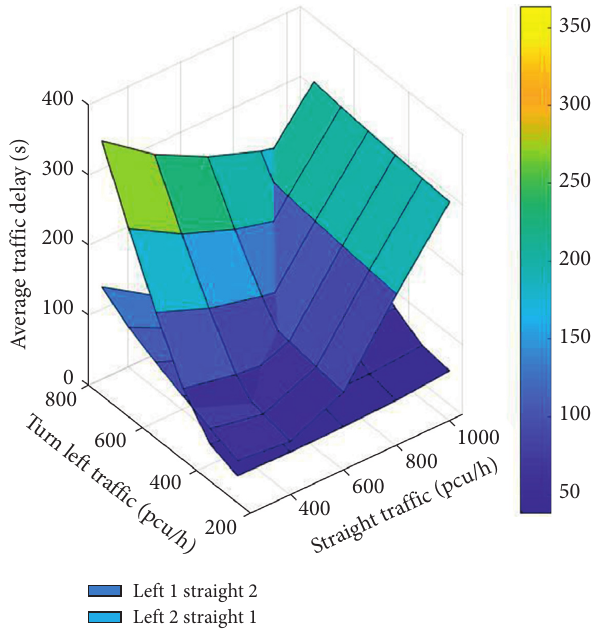
Figure 10: Change in the two-way delay under different lane combinations on three entrance lanes.